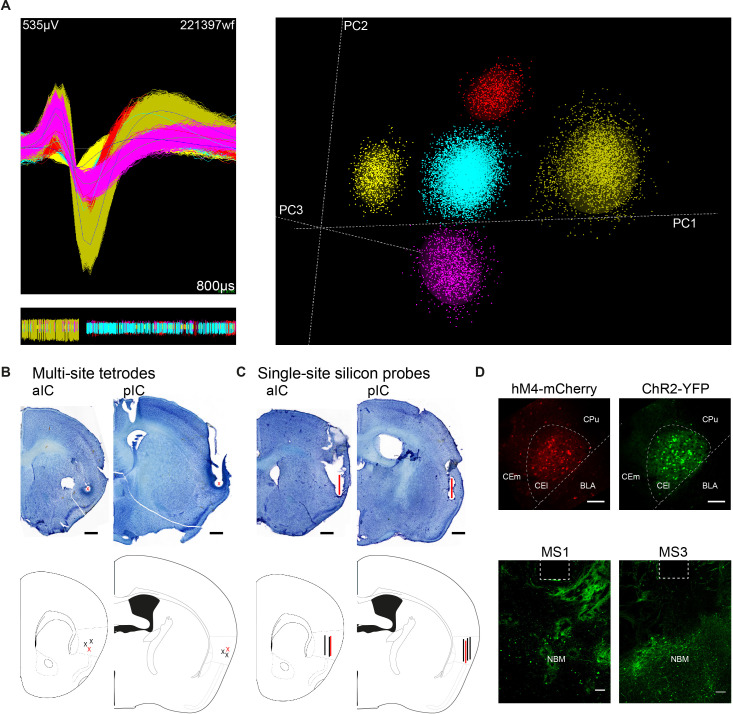
Raw data and histological assessment of IC recordings.(A) Example waveforms of five single units (top, left) and their corresponding representation in PC space (right) from two recording sessions on separate days (bottom, left). (B) Nissl staining of tissue from an animal implanted with multi-site tetrodes in aIC (top, left) and pIC (top, right) and corresponding summary schema of all multi-site implantation sites (bottom). Red ‘X’s indicate corresponding electrolytic lesion sites in both staining and schema. Scalebar = 500 μm. (C) Nissl staining from tissue of animals implanted with single-site 16 Channel silicon probes in aIC (top, left) and pIC (top, right) and corresponding summary schema of all single-site implantation sites (bottom). Red lines indicate corresponding electrolytic lesion sites between staining and schema. Scalebar = 500 μm. (D) Viral expression of Cre-dependent hM4-mCherry (top, left) and ChR2-YFP (top, right) in the CE and corresponding projection fields with optic fiber (400 μm) position above NBM (bottom) in two multi-site recorded PKCδ::Cre animals. Scalebar = 100 μm.